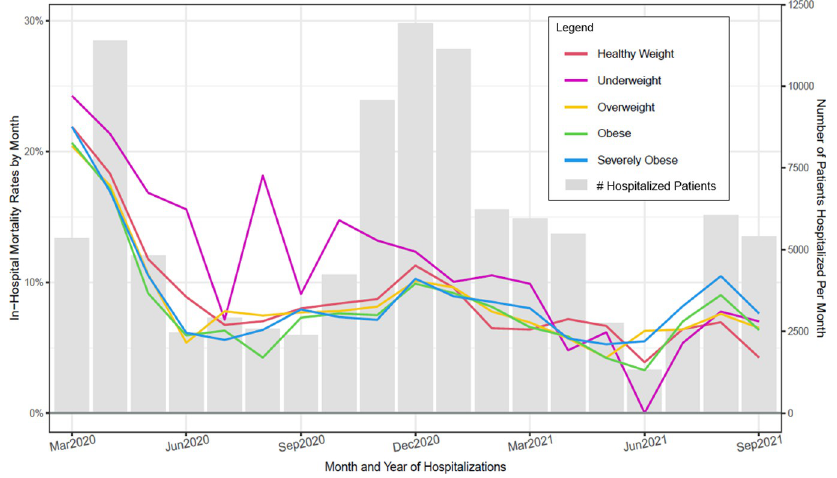
Fig 7. Observed in–hospital mortality rates (Deaths/hospitalizations) and number of patients hospitalized per month for patient BMI groups (March 2020 through September